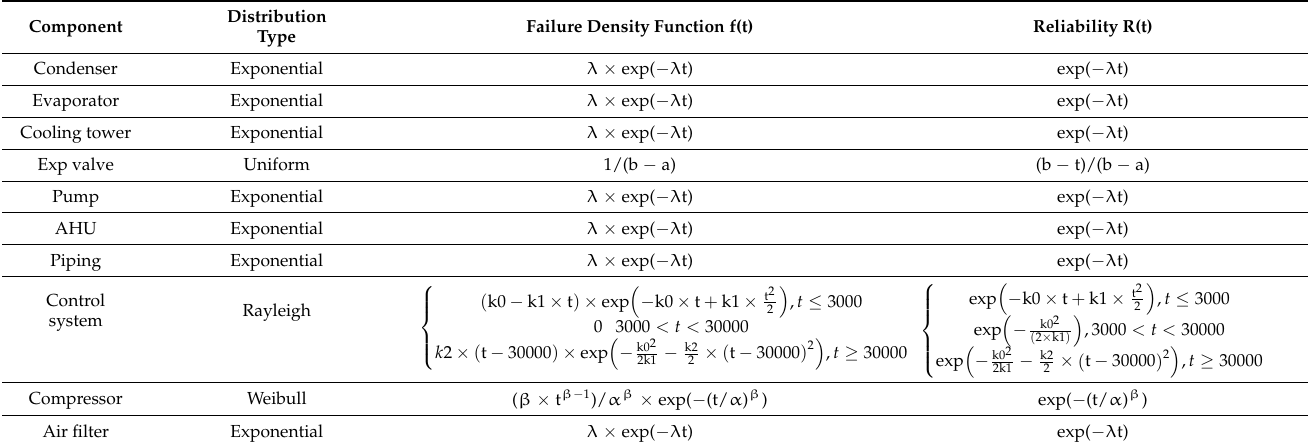
Table 2. List of failure density and reliability functions for each